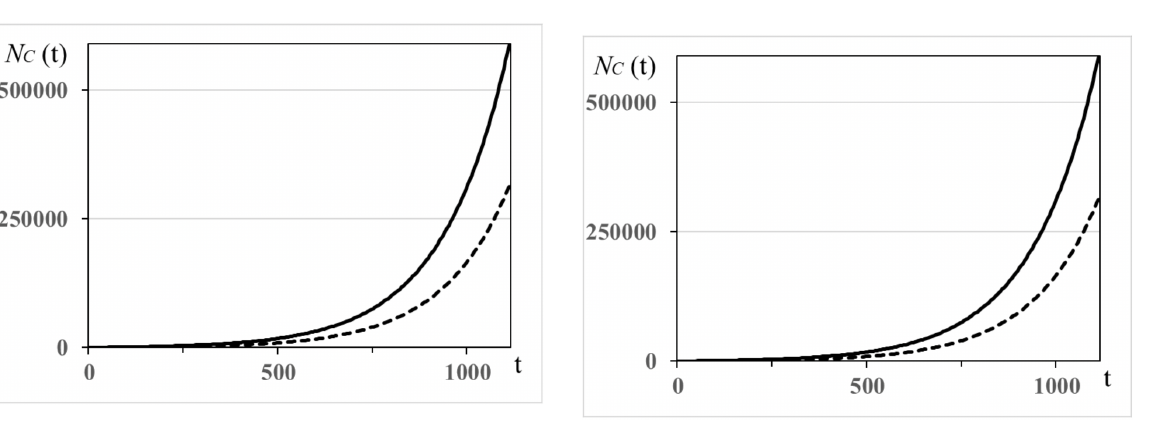
Fig. 12. Graphs of N C ( t ) for unstable dynamics for 2 different initial values ϕ ( a )